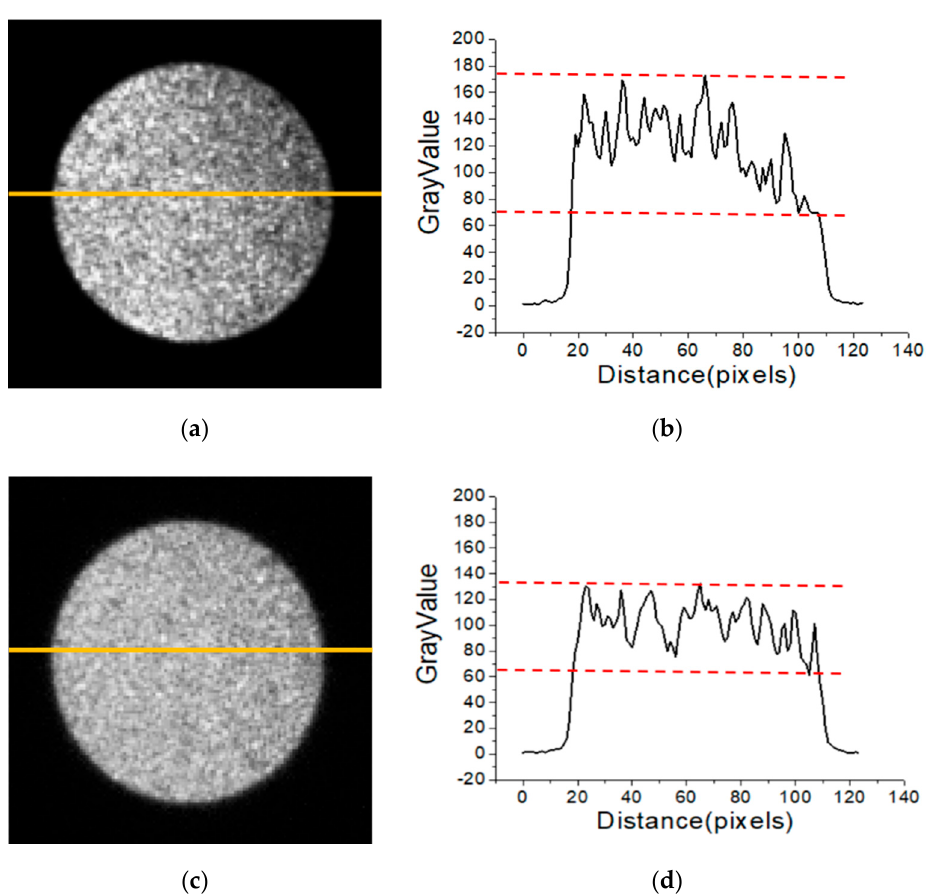
Figure 4. The speckle patterns and their 1D intensity distributions are shown when the incident angles of the Gaussian beam θ = 0.5° and 1° with a multimode fiber of length L = 7 m. ( a ) Speckle patterns under the condition of θ = 0.5° and L = 7 m, SC = 0.17; ( b ) 1D intensity distribution corresponding to ( a ); ( c ) speckle patterns under the condition of θ = 1° and L = 7 m, SC = 0.13; ( d ) 1D intensity distribution corresponding to ( c ). The 1D intensity distribution is extracted from the yellow line.